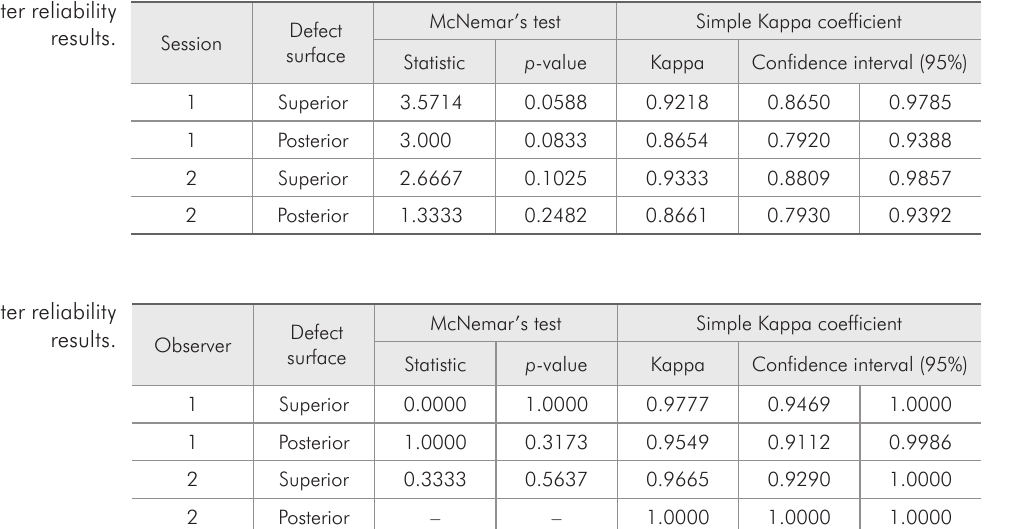
Table 1 - Inter-rater reliability